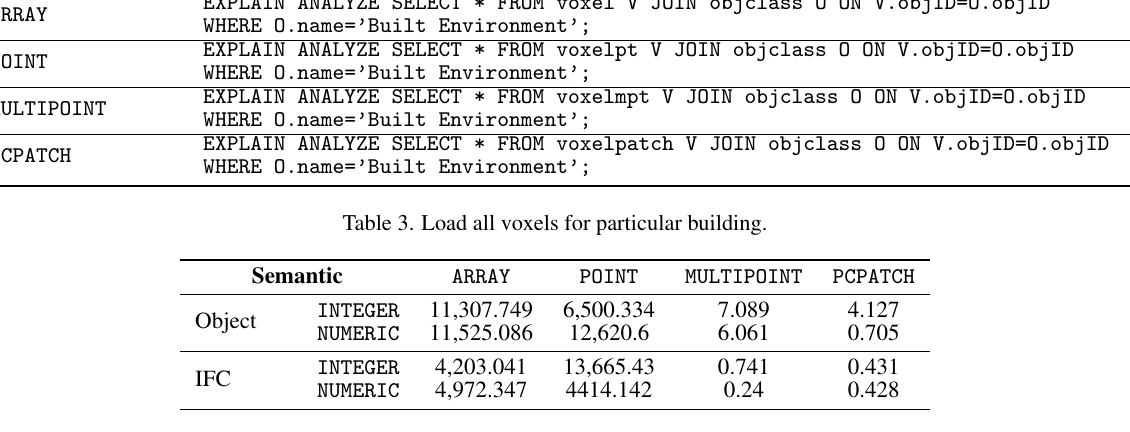
Table 4. The query times for four queries using the dataset. All times are in milliseconds.